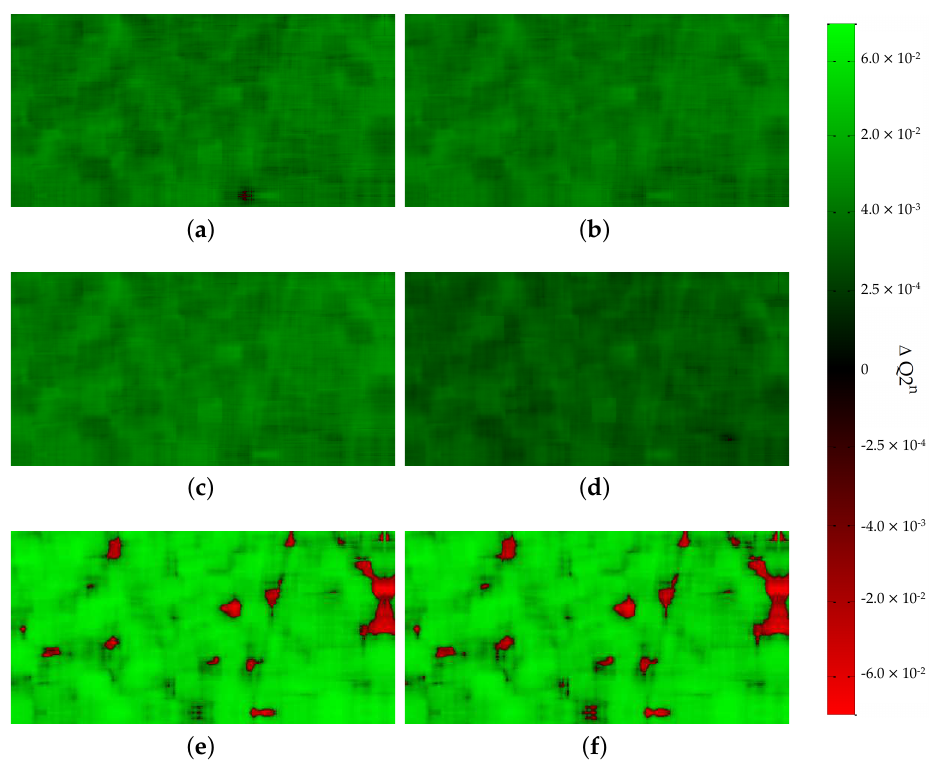
Figure 6. Tripoli dataset (RR): differences between the Q2 n maps computed for the best algo- rithm, i.e., MBFE-GSA-MLR, and the baseline methods, i.e., ( a ) GSA, ( b ) GLP-MLR, ( c ) GLP-CBD, ( d ) MBFE-GSA-CBD, ( e ) GLP-HPM and ( f ) MBFE-GSA-HPM. Green values: better results obtained by MBFE-GSA-MLR; red values: better results obtained by the other